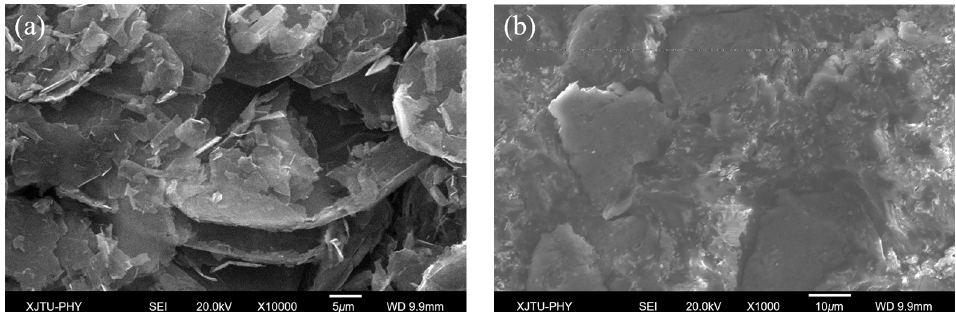
Figure 1. SEM images of ( a ) graphene and ( b ) the fracture surface of polymer coating (4.0 wt % graphene).